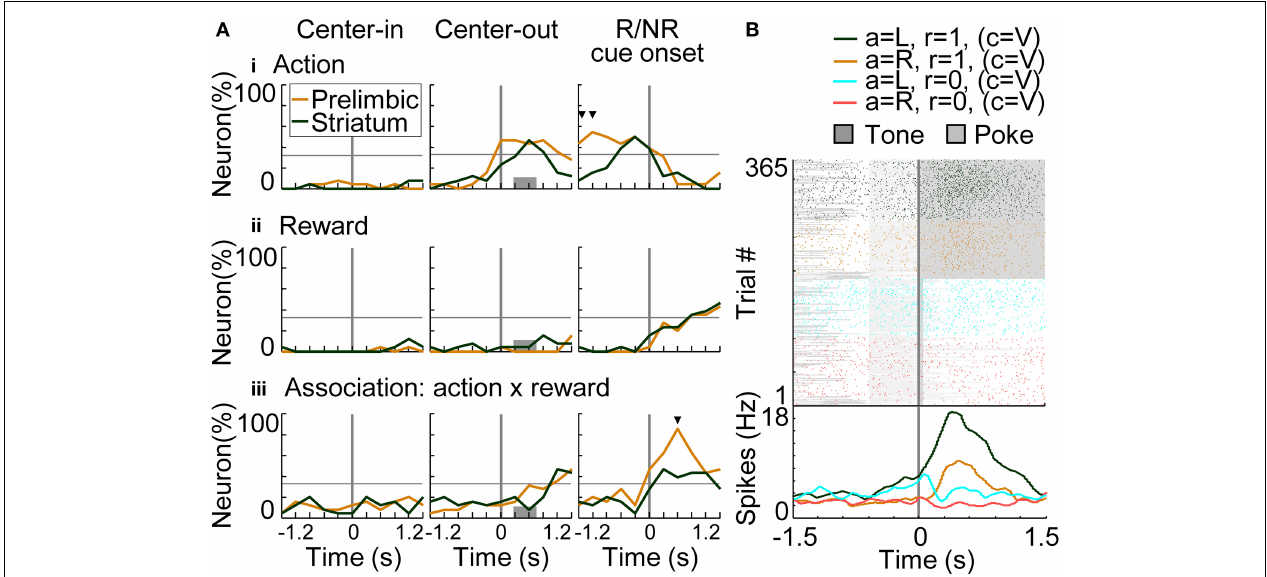
FIGURE 8 | Coding of response-outcome (R-O) association. (A) The proportion of neurons coding actions (responses: R) (i) , rewards (outcomes: O) (ii) and R-O associations (iii) . In regression analysis with variable-reward-condition trials, the proportion of neurons with significant regression coefficients is shown: p < 0 . 01 in a two-sided Student’s t -test. Orange and green lines indicate neurons in the prelimbic cortex and dorsomedial striatum, respectively. When the proportion of neurons exceeded the threshold (32.3%), we defined that the prelimbic cortex or the striatum significantly represented the variable ( z -test, p < 0 . 05). In each column, proportions of neurons are aligned with a different timing: left, initiation of center-hole poking; middle, end of center-hole poking; right, onset of reward or no-reward cue (R/NR cue). Gray bars in the middle